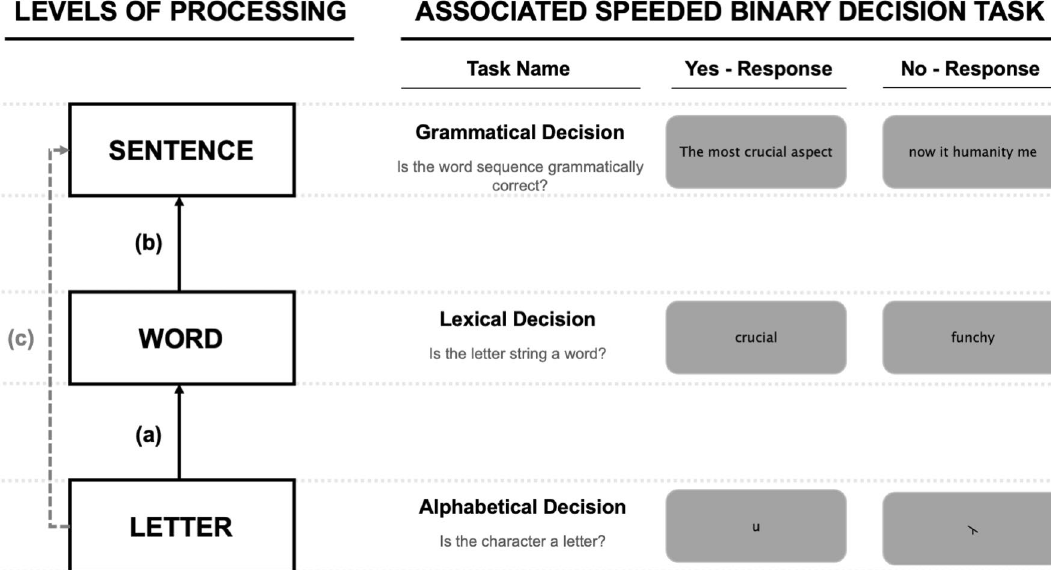
Figure 1. A hierarchical model of reading with letter, word, and sentence level representations. The figure illustrates the central hypothesis to be tested in the present study—that letters connect with words (a) and words with sentences (b), but letters do not directly connect with sentences